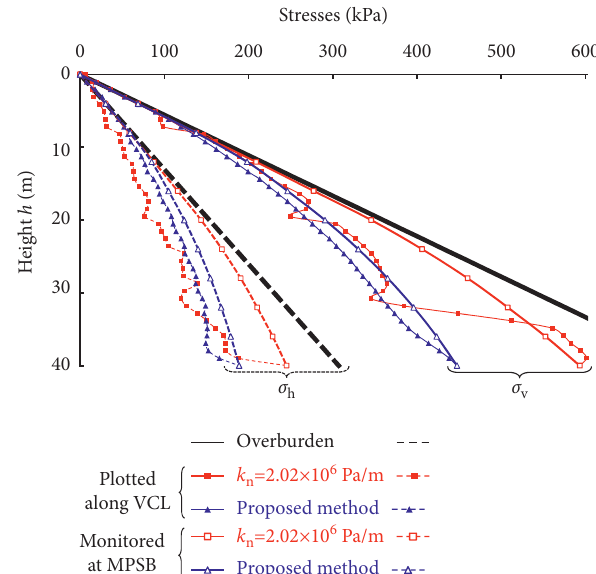
Figure 9: Vertical ( σ v ) and horizontal ( σ h ) stresses plotted along VCL and monitored at MPSB with different normal stiffness (k) n of interfaces.